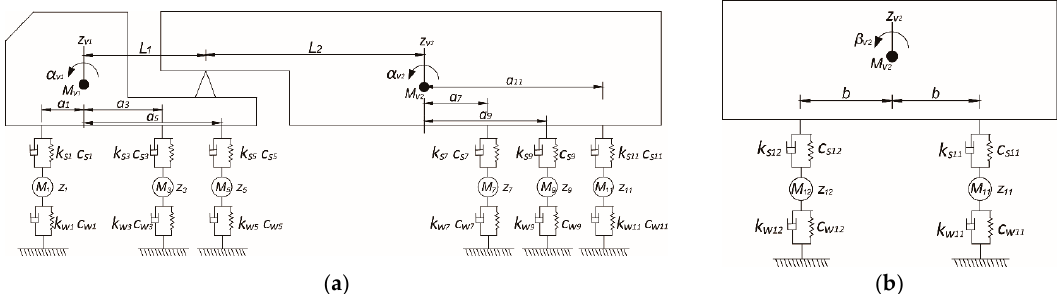
Figure 2. Whole vehicle model of a 6-axle trailer truck. ( a ) Length direction ( b ) Width direction.